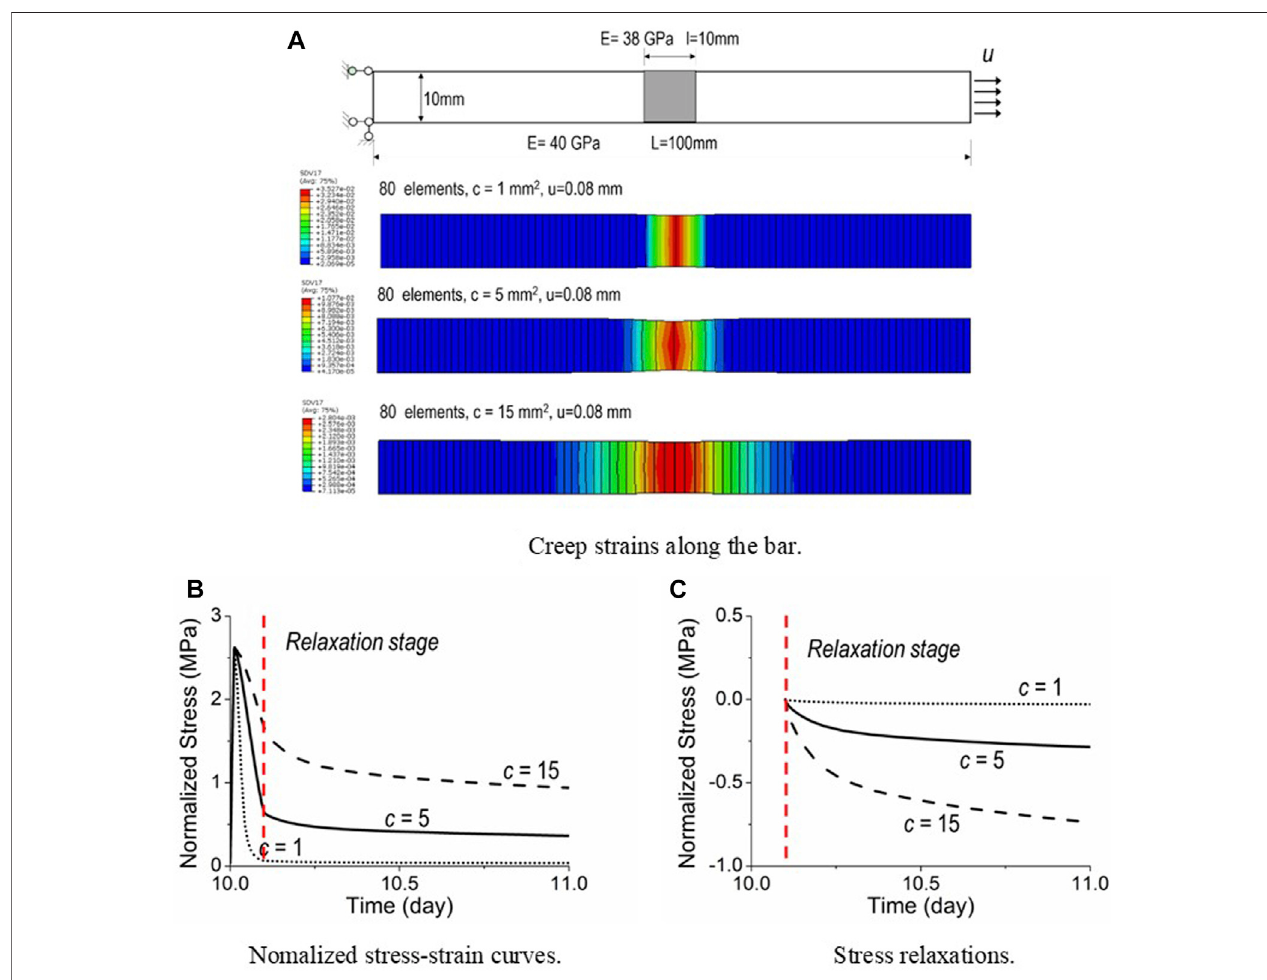
FIGURE 6 | Simulations of creep behaviors intertwined with damage with different c .